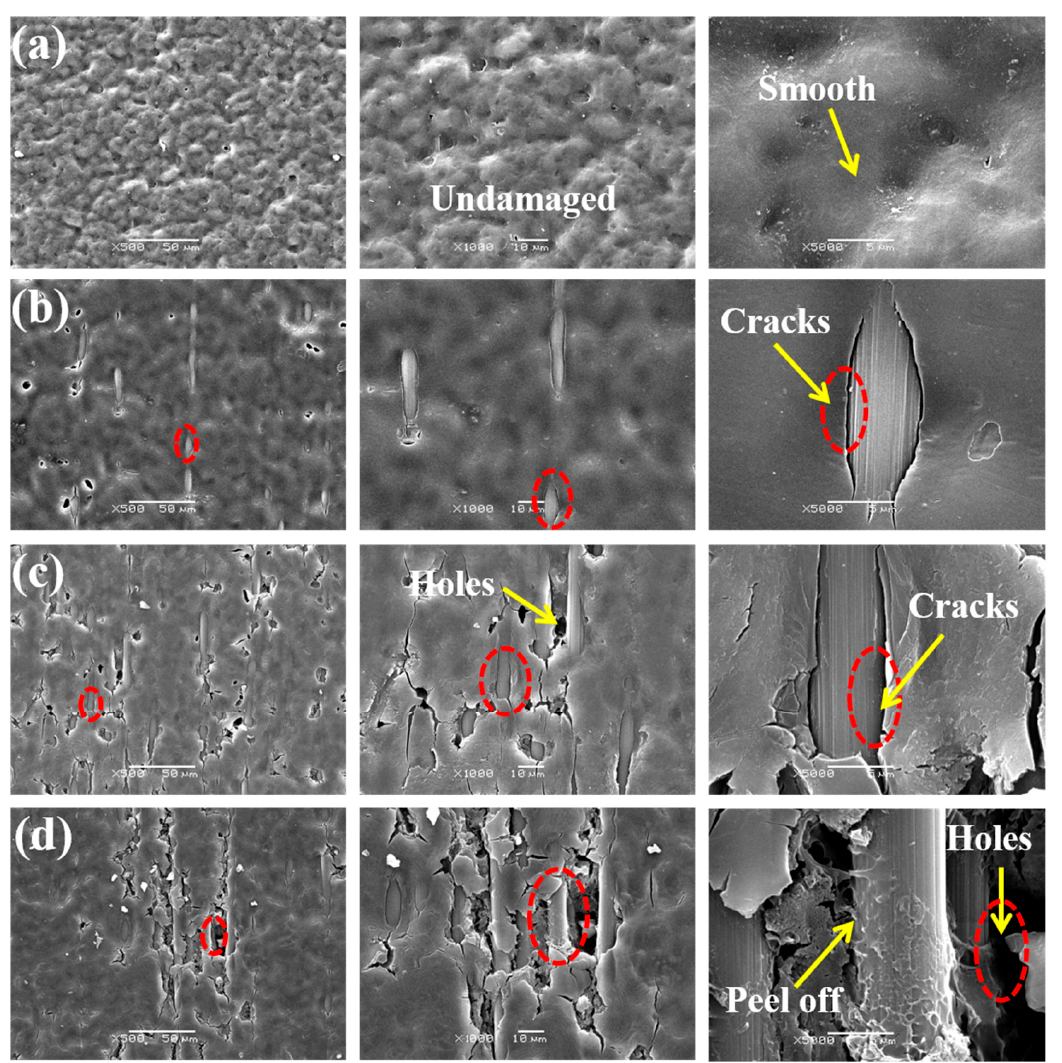
Figure 10. Surface microscopic morphology of CFRP specimens with different UV aging times: ( a ) unaged; ( b ) 10 days; ( c ) 40 days; ( d ) 80 days.